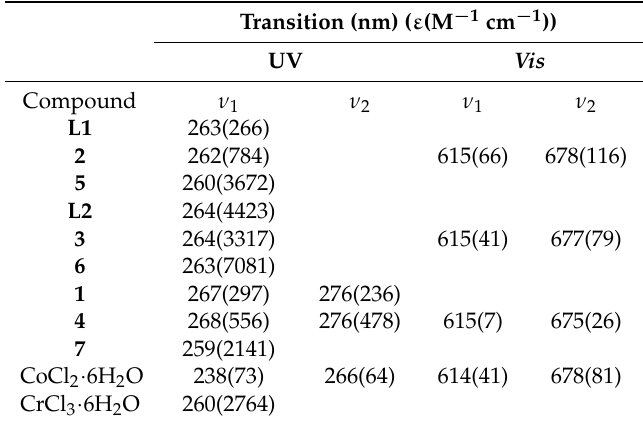
Table 2. Some bands for the starting salts, ligands and complexes 2–7 observed in their UV/Vis